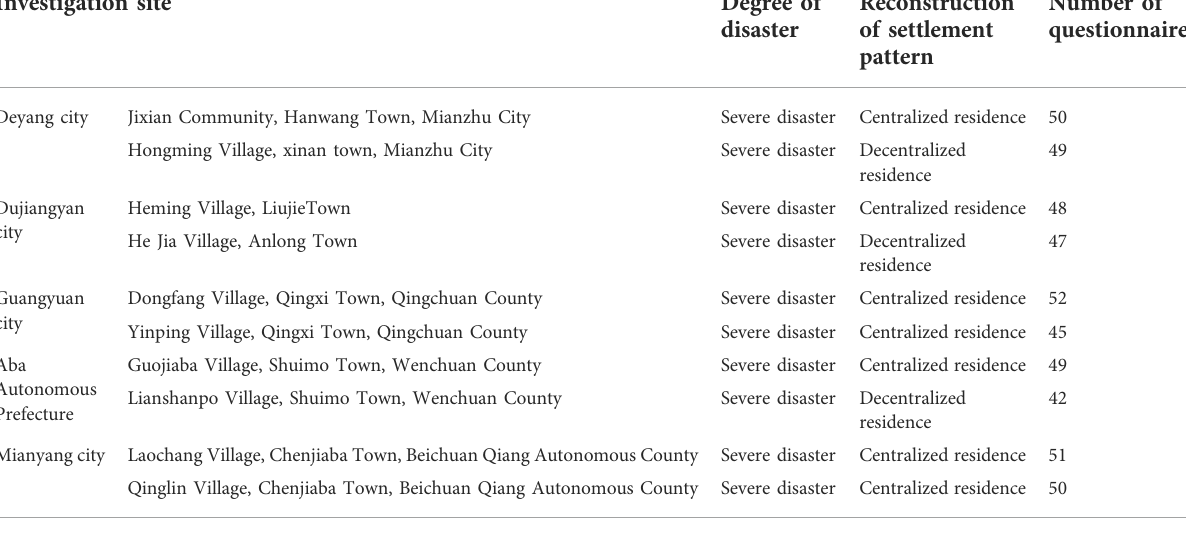
TABLE 4 Sample villages and the numbers of questionnaires collected.